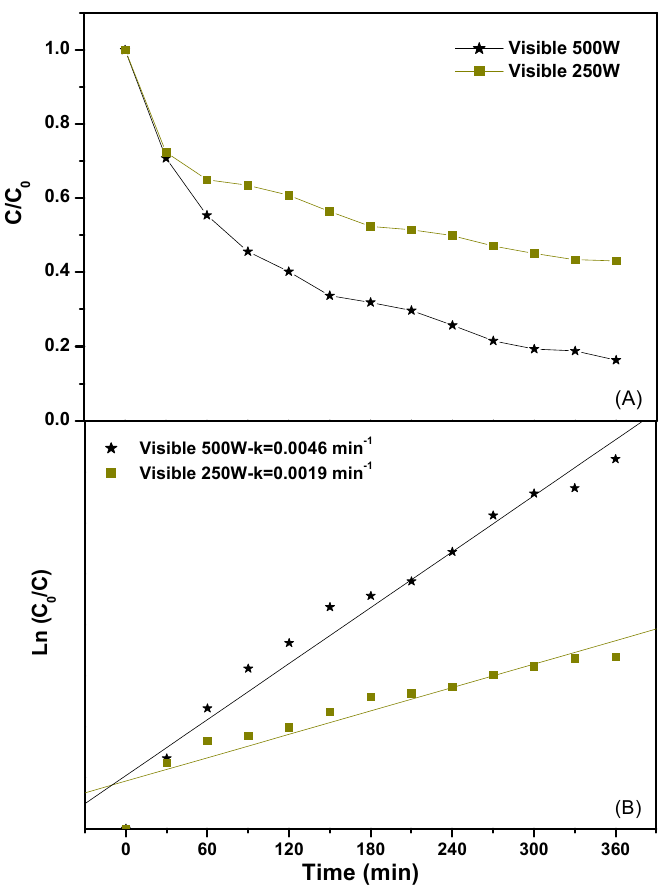
Figure 14. Effect of the light intensity on the photocatalytic degradation efficiency of Direct Orange 26 ( A ); and the first-order kinetic plots for the photocatalytic degradation of Direct Orange 26 ( B ) with different light intensity under visible light irradiation.